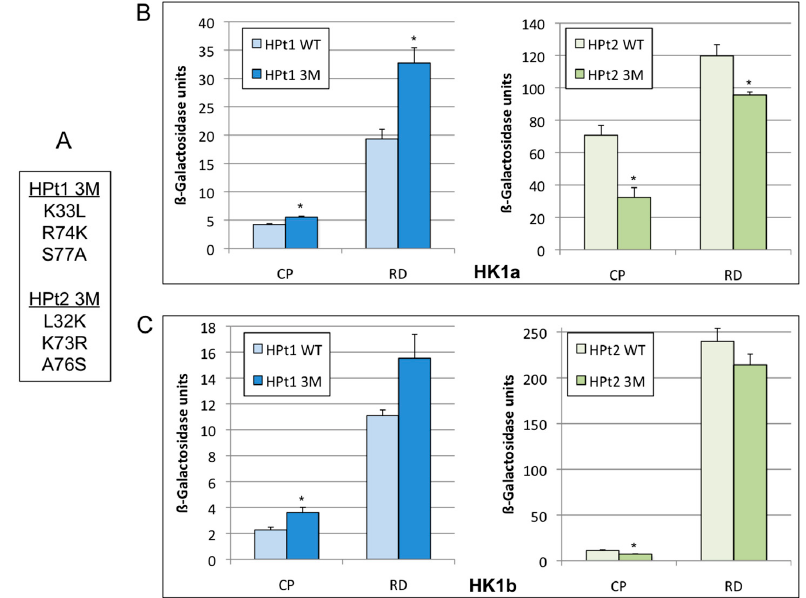
Figure 4. Interaction test with HPt mutants. ( A ) Mutated amino acids in the HPt1 and HPt2 triple mutants (3M); ( B ) β -Galactosidase activity for each HK1a/HPt interaction is plotted with mean values of at least four independent assays performed in triplicate and represented with standard error bars. Significant differences from the wild-type (WT) interaction are represented by * with p < 0.05; ( C ) Same dosage for each HK1b/HPt interaction is plotted in the same representation. Significant differences from the wild-type (WT) interaction are represented by * with p < 0.05.